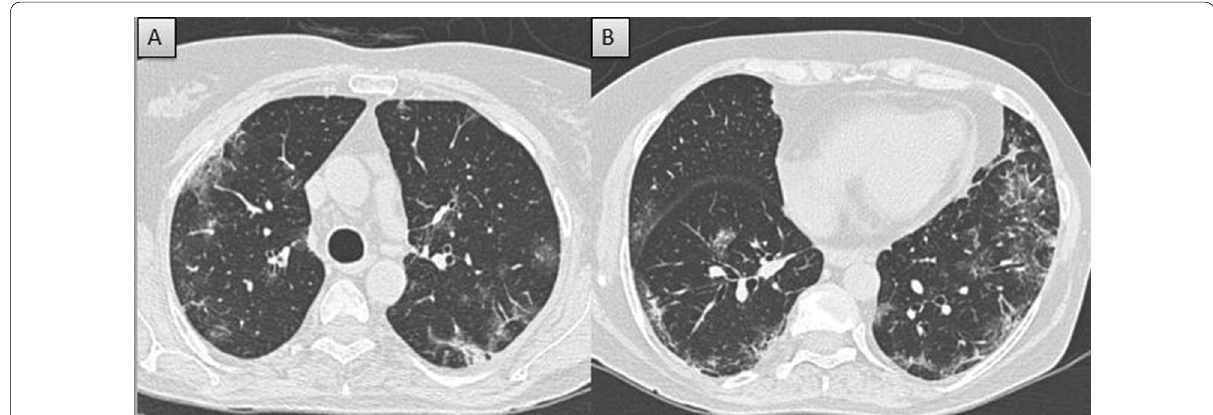
Fig. 4 Moderate severity in partially vaccinated patient: A and B Axial CT thorax (lung window) of a 61-year-old COVID pneumonia patient who had received single dose of Covid vaccine shows diffuse peripheral patchy ground glass opacities and interstitial thickening with CT severity score of 14/25 (moderate severity)